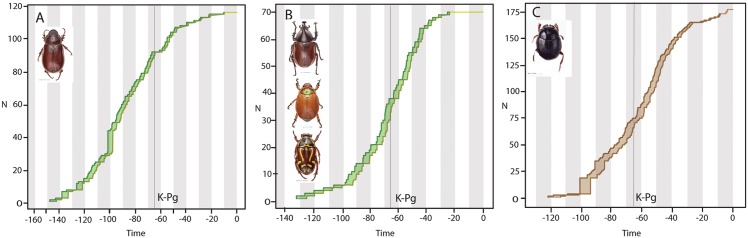
Lineage through time plots of scarab clades.A) Melolonthinae (leaf feeders) B) CRD clade (specialist angiosperm feeders) C) Scarabaeinae (dung feeders). Shaded areas represent congruent estimates from analyses CS2, CS3, CSiii and CSiv estimated by Penalized Likelihood methods with divergence maxima plotted from CS2 and minima from CSiii.